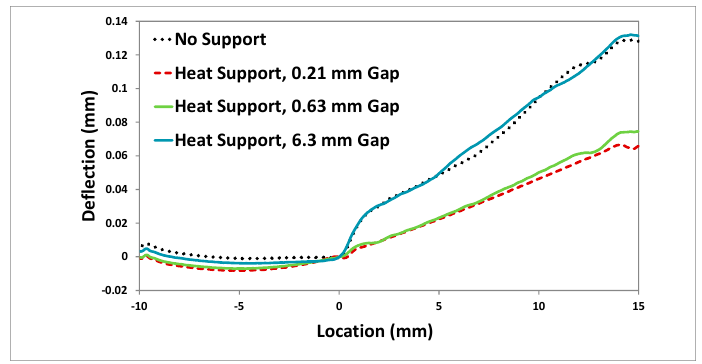
Figure 7. Overhang part surface profile comparison between different heat-support cases.